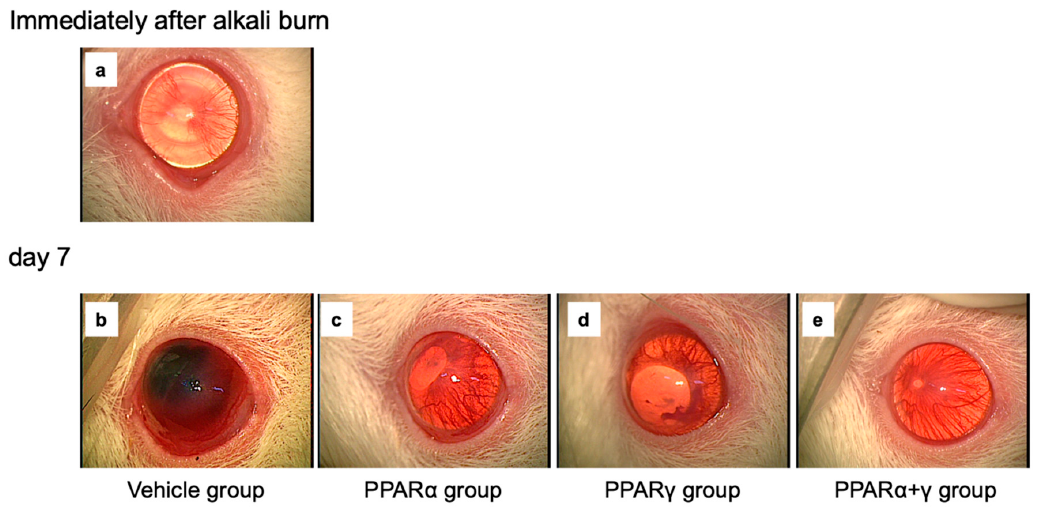
Figure 1. Anterior segment photographs of the cornea in each group after alkali burn. In the cornea immediately after the burn, blood vessels of the iris disappeared, and a circular epithelial defect line was observed ( a ). Anterior chamber bleeding occurred in the vehicle group ( b ). The central opacity and neovascularization of the cornea were less severe in all peroxisome proliferator-activated receptor (PPAR) groups than in the vehicle group on day 7 ( c – e ). In the PPAR α + γ group in particular, the corneal opacity was quite slight ( e ).